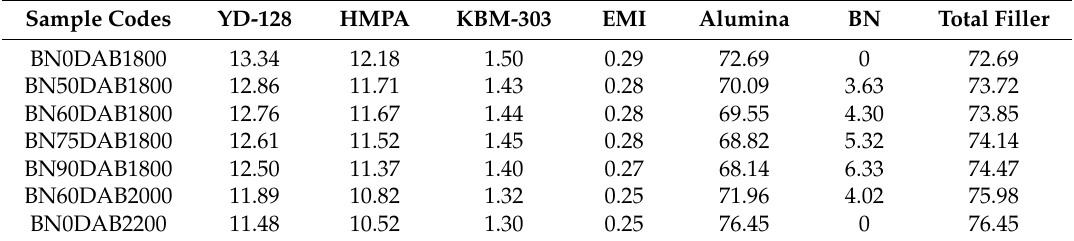
Table 1. Sample codes and formulation of epoxy resins filled with alumina and boron nitride